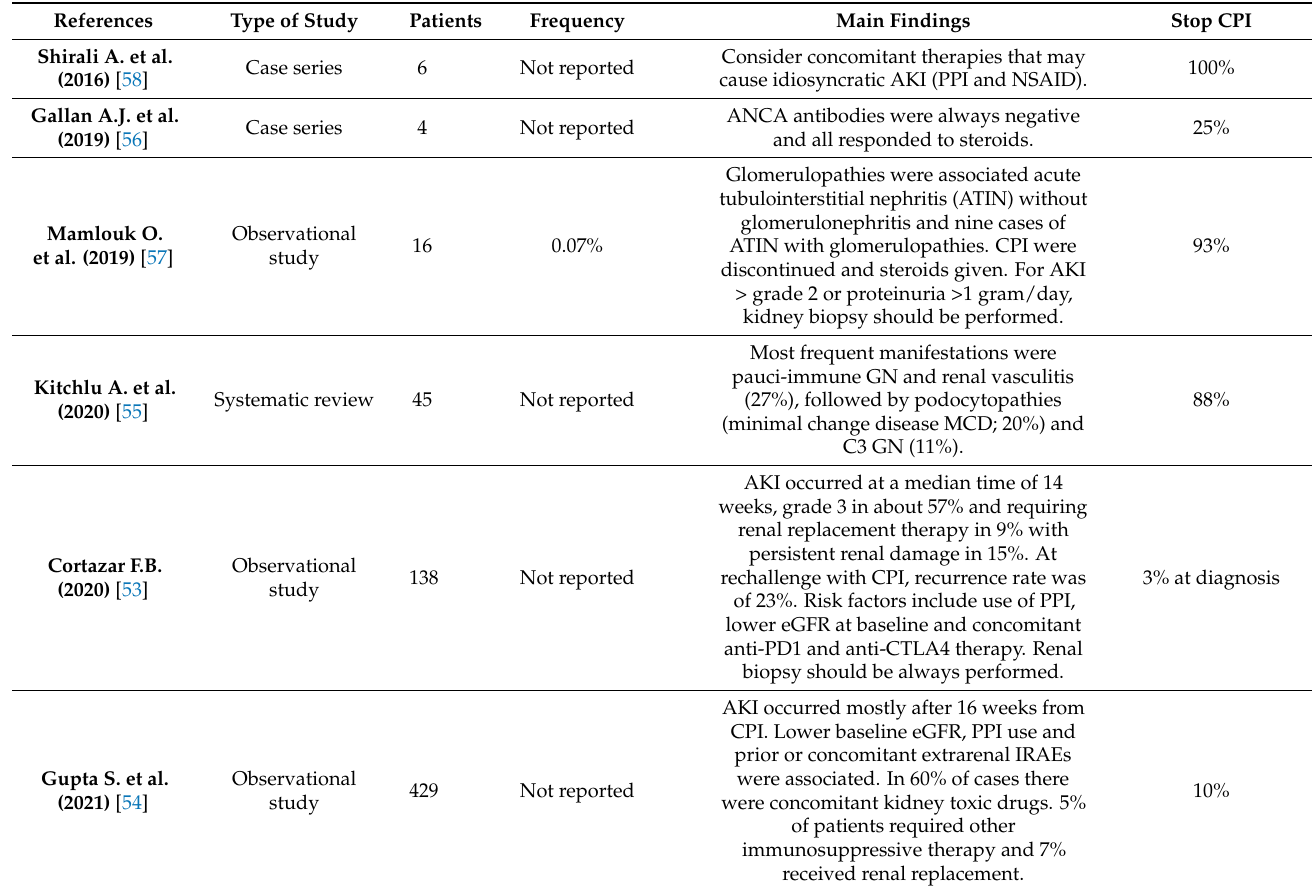
Table 6. Nephrotoxicities after checkpoint inhibitors